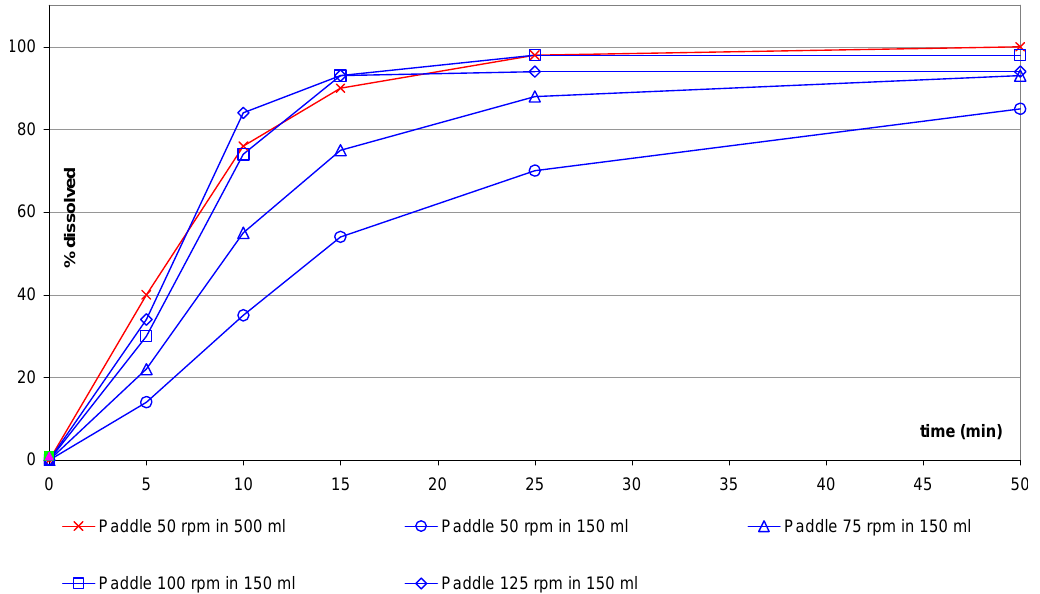
Figure 5. IR(1) tablets: comparison of small vessel accessories versus one liter